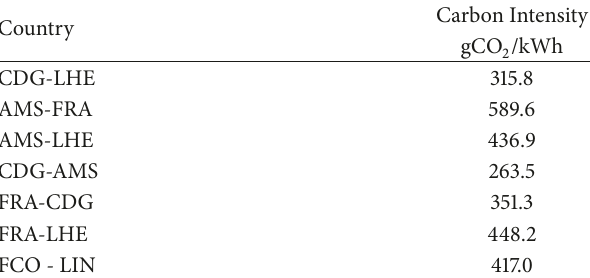
Table 5: Route-specific CO 2 emission